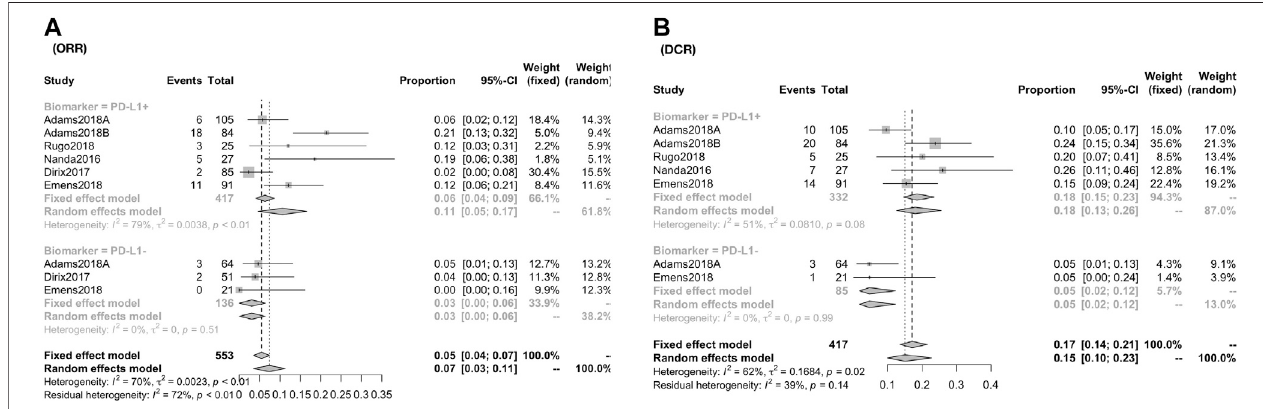
FIGURE4| GlobalresponserateandriskestimatebetweenPD-1+andPD-L1 − forpatientsofORR (A) andDCR (B) .TheORRwas10.62%(95%CI,4.67 – 16.56; I 2 ,78.80)vs.3.07% (95%CI,0.00 – 6.43;I 2 ,0.00) [RR, 2.935(1.189, 7.244)];theDCRwas17.95%(95% CI,12.61 – 25.55;I 2 ,51.30) vs.4.71%(95% CI,1.81 – 12.25;I 2 , 00.00) [RR, 3.584 (1.337,